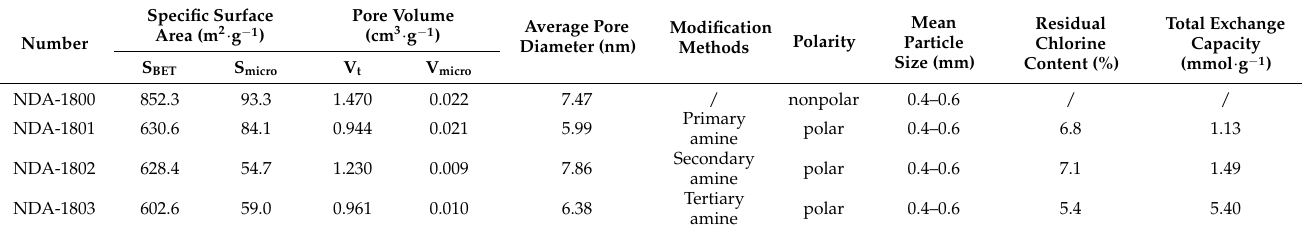
Table 2. Characterization of the modified resins.